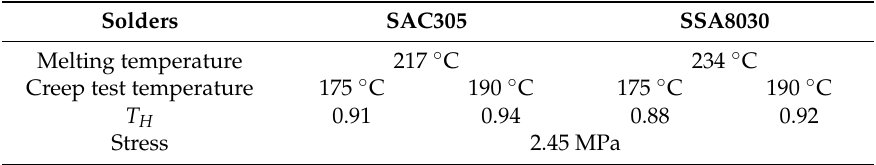
Table 1. Conditions of the creep test.